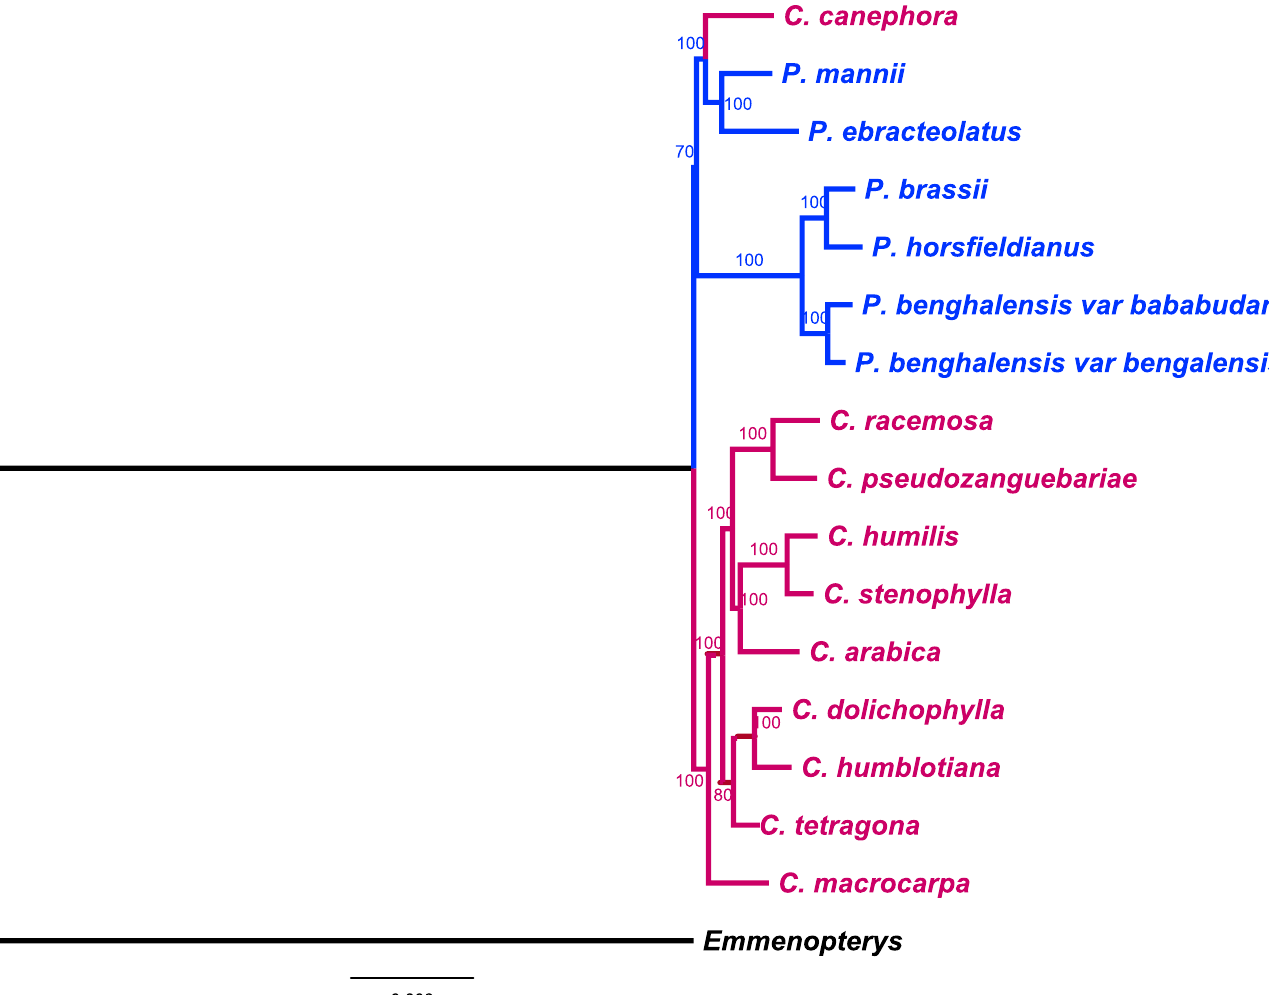
Fig 5. Maternal phylogenetic relationships. The ML phylogenetic tree was constructed based on a set of 16 coffee trees representatives of the main geographic clades, and whole chloroplast sequences study using Emmenopterys henryi as outgroup. Psilanthus (in blue) and Coffea (in red) species clustered into two well-supported clades with the exception of C . canephora belonging to the Psilanthus